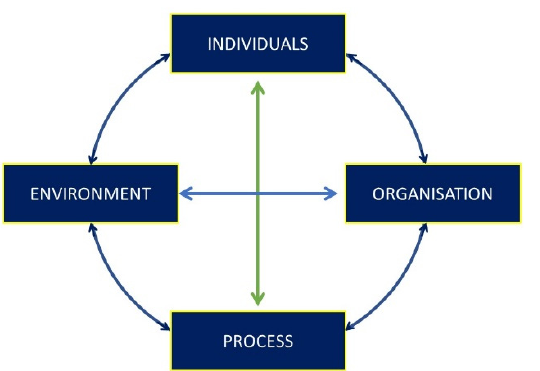
Figure 2. A framework for describing new social entrepreneurship creation. Source: Authors.